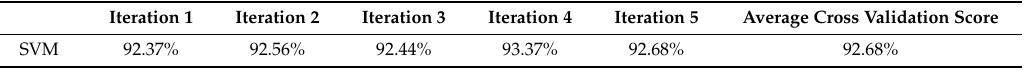
Table 1. Classification accuracy for the support vector machine model.